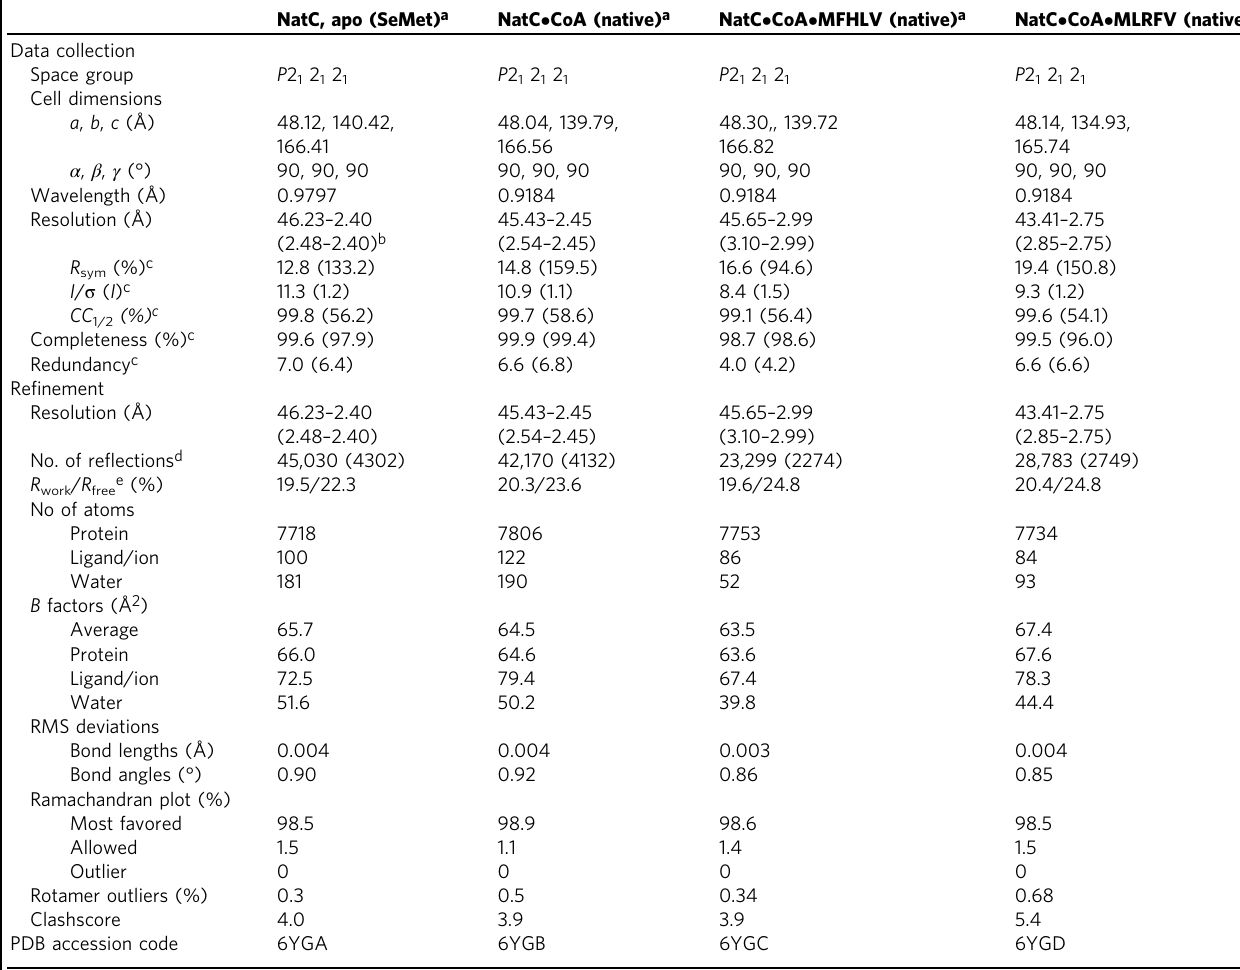
Table 1 Data collection and re fi nement